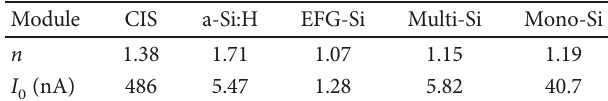
Figure 12: V versus I yielding ideality factor and reverse oc sc saturation current of the various module technologies. Table 6: Parameters ( n and I ) obtained for various module 0 - I technologies from V oc sc